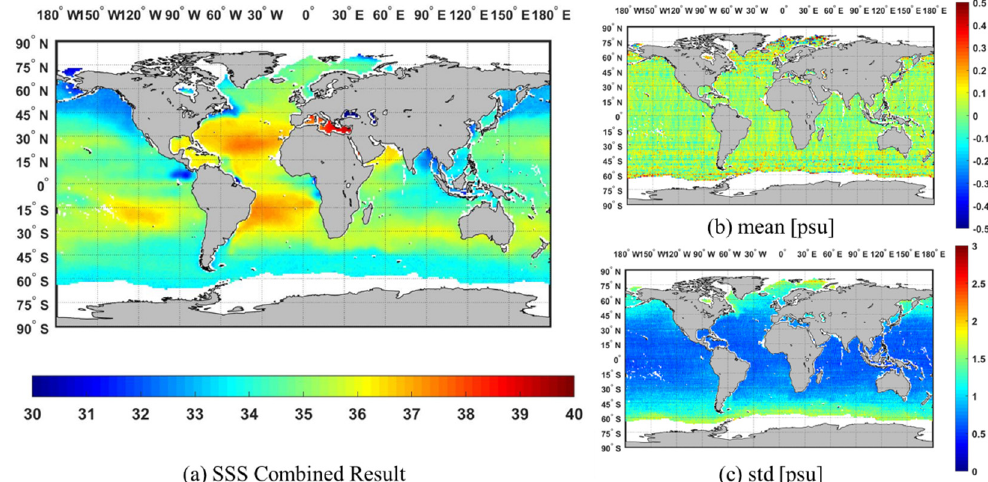
Figure 7. Monthly Sea Surface Salinity (SSS) combined results in a 100 × 100 km grid. ( a ) Monthly SSS map from combined retrieval, ( b ) the mean value of the retrieved SSS minus the initial field, and ( c ) the standard deviation of the retrieved SSS compared with the initial field.